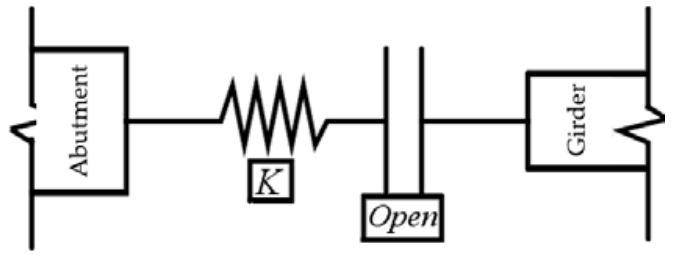
Figure 3. The element model for gap.